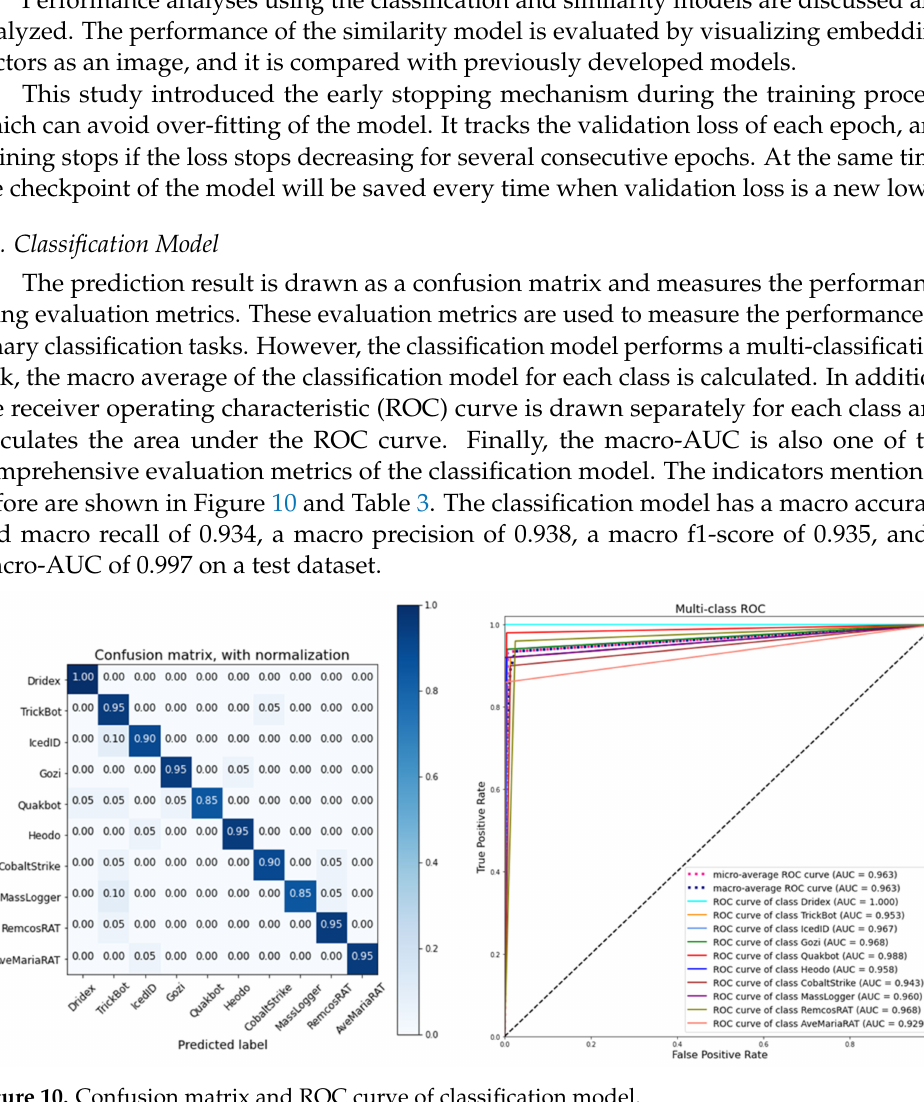
Figure 10. Confusion matrix and ROC curve of classification